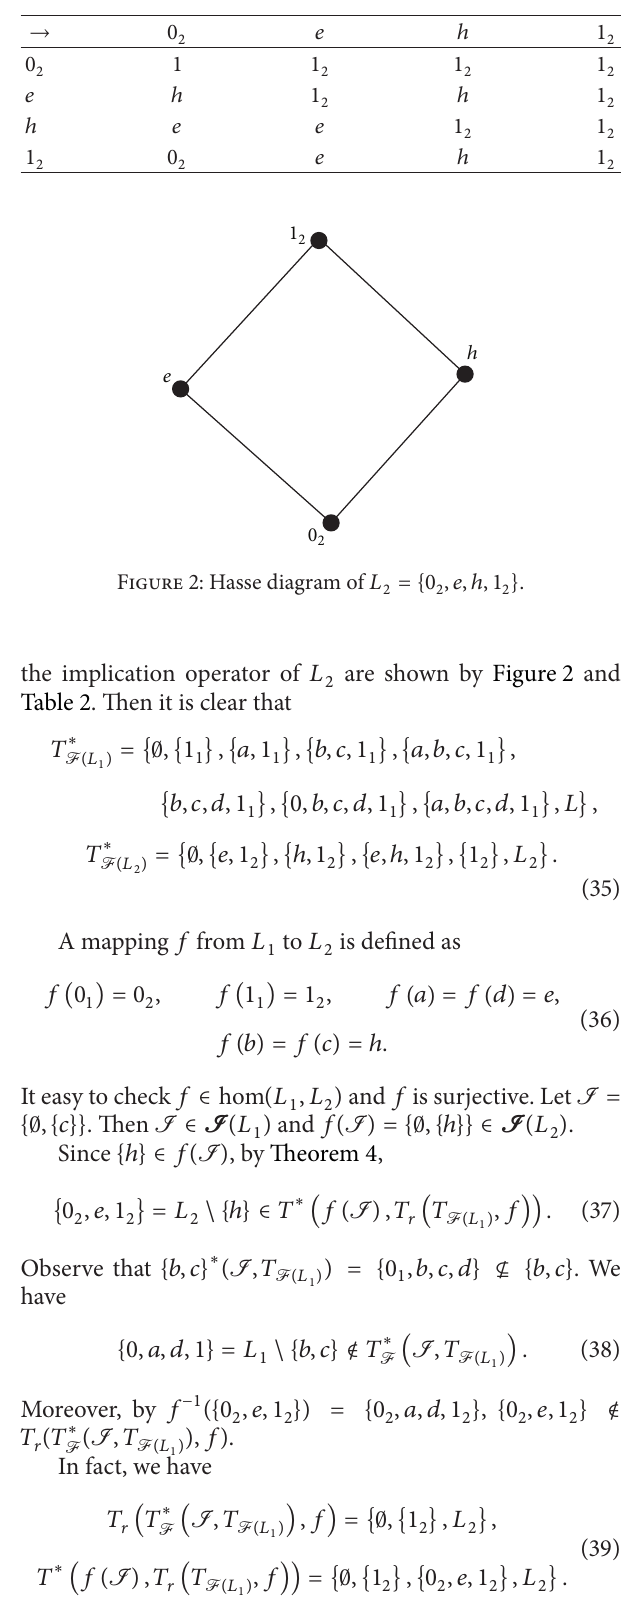
Table 2: The implication operator of 𝐿 2 = {0 2 ,𝑒,ℎ,1 2 } .